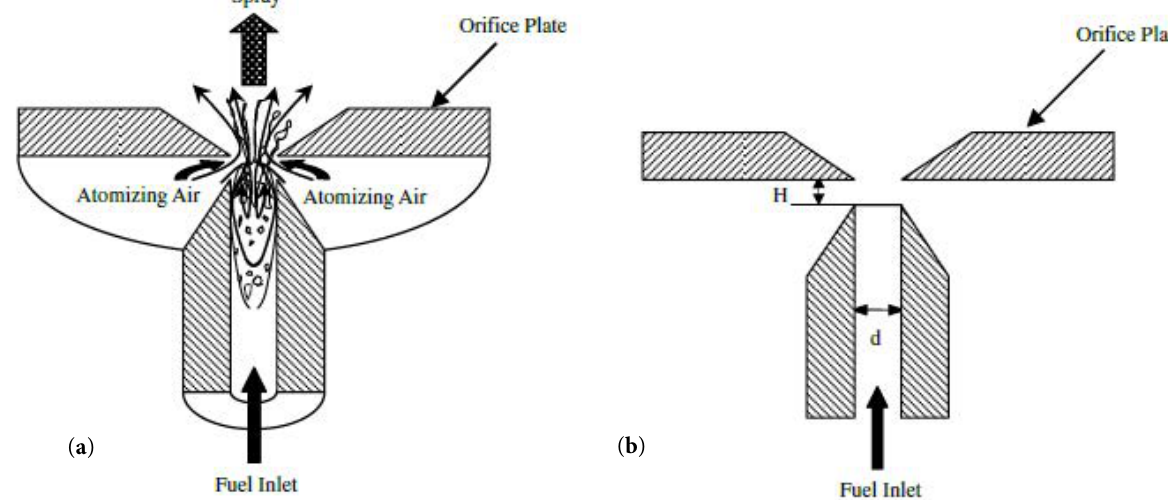
Schematic of the flow-blurring injector: ( a ) flow structure and ( b ) geometric details [80].